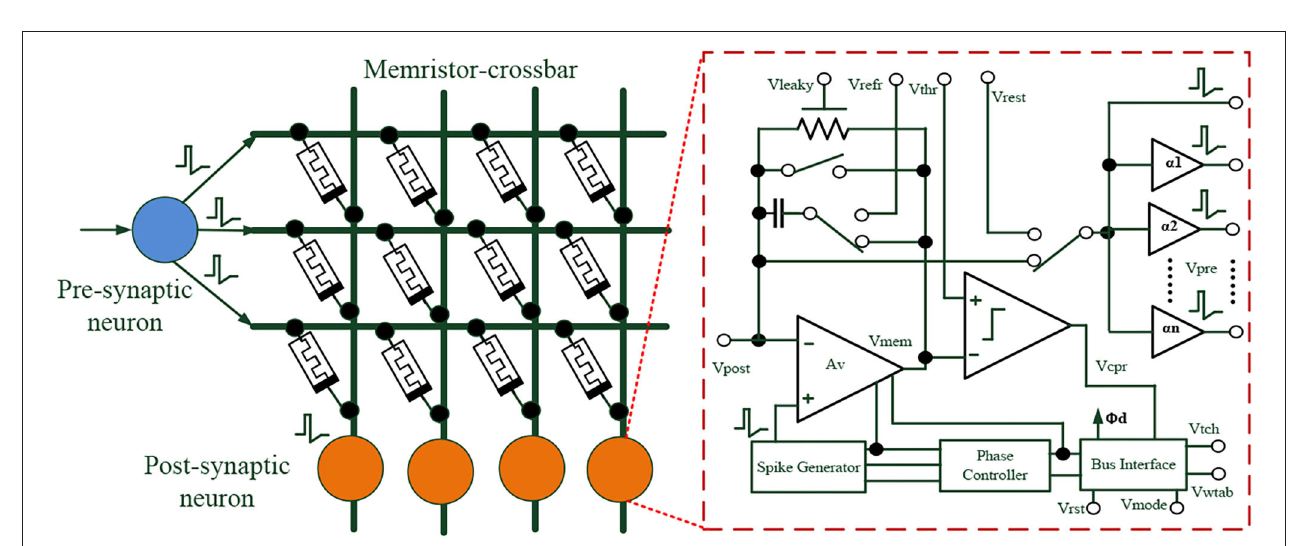
FIGURE 8 | CMOS-Memristor SNN (Wu and Saxena,